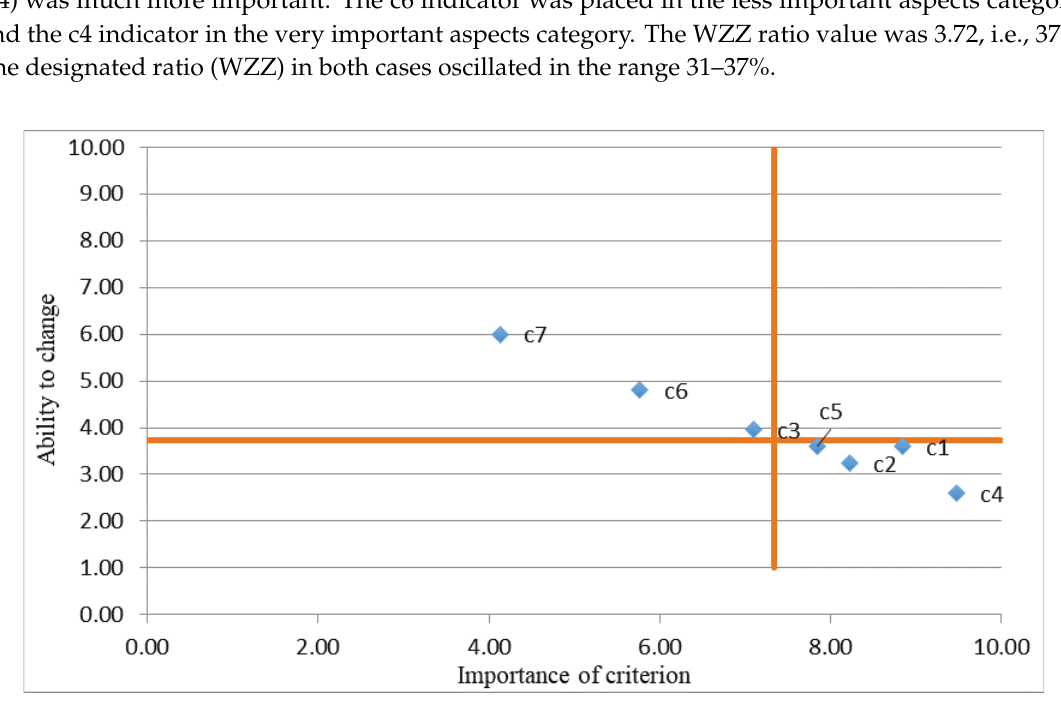
Figure 3. Dependency of the ability to change on the importance of the criterion (Stage 2).